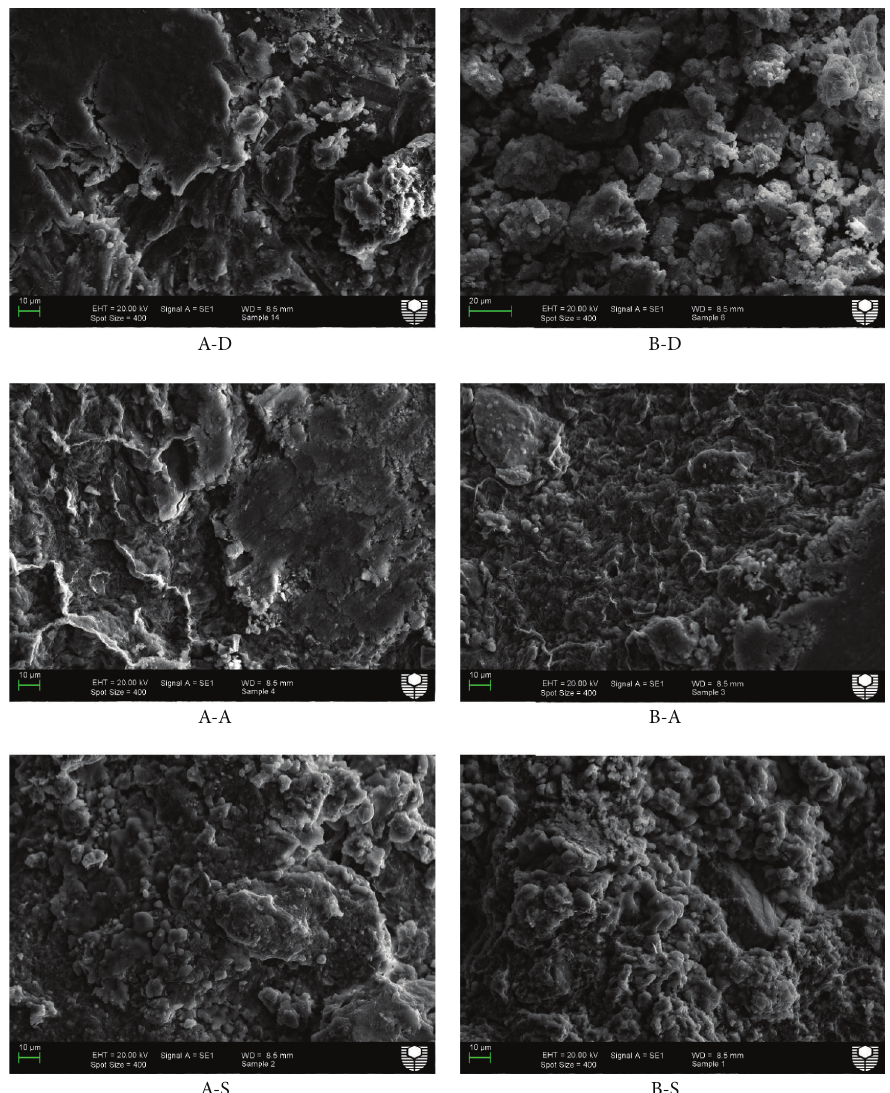
Figure 2: The SEM views of bentonite particles in the GCL samples under the following conditions: A-D and B-D: initial status before hydration; A-A and B-A: after hydration with distilled water; A-S and B-S: after hydration with the NaCl solution.